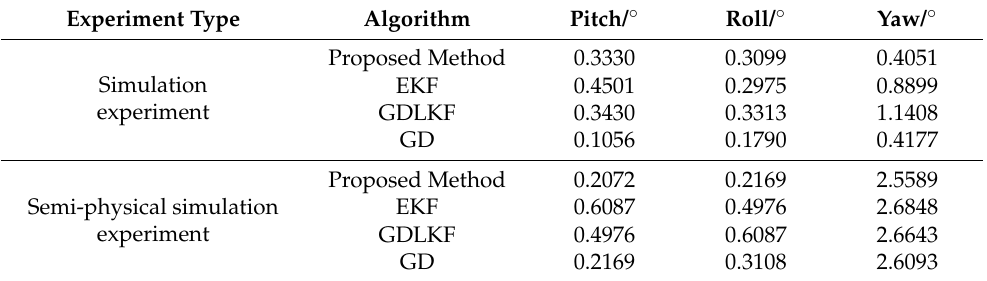
Table 2. Root mean square error of simulation experiment and semi-physical simulation experiment. Experiment Type Algorithm Pitch/